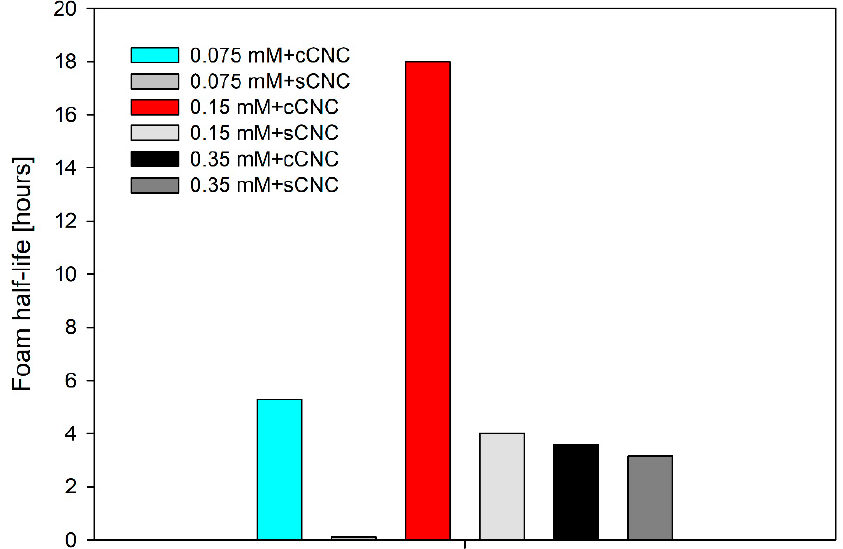
Figure 9. Initial foam volume obtained from 15 mL of LAE-cCNC or sCNC dispersed with double- syringe method. Foam volume was recorded 1 min after the foaming cycle.